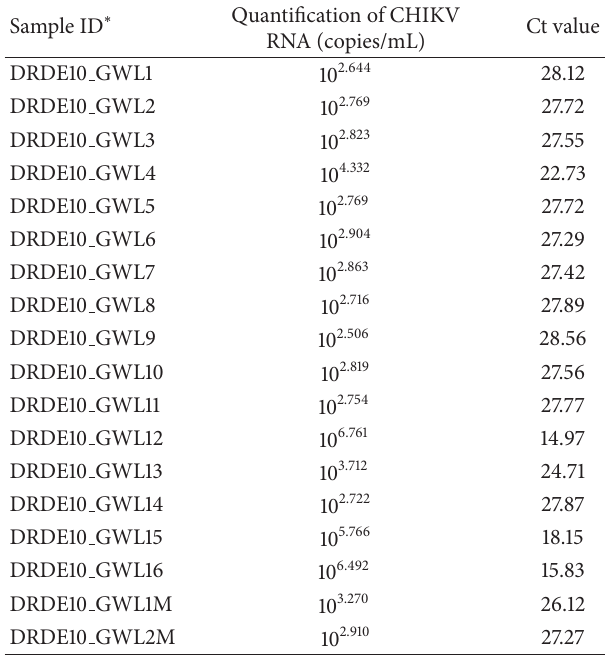
Table 1: Signs and symptoms of Chikungunya infected patients. Sign and symptoms